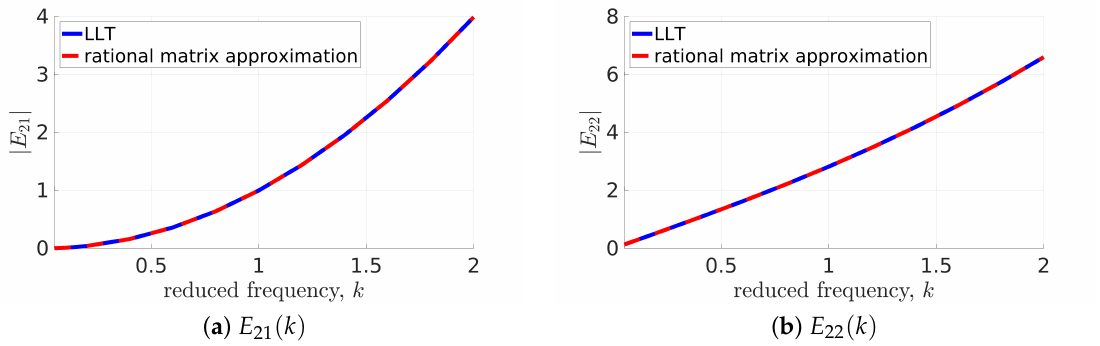
Figure 15. Comparison between computed and approximated magnitude of transfer functions E 21 ( k ) and E 22 ( k )